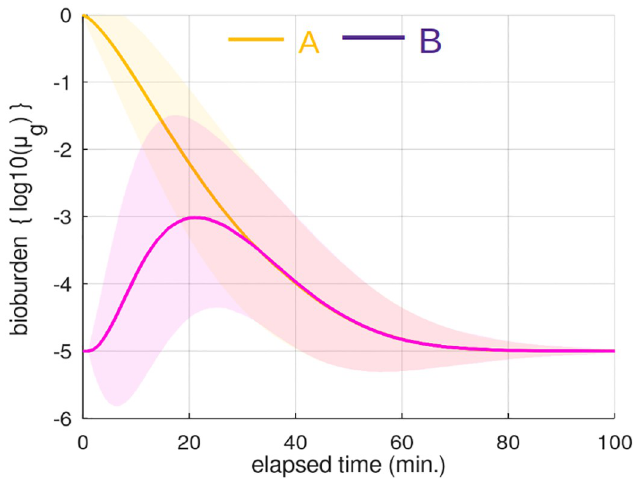
Fig 5. Bioburden. Geometric mean bioburden (log10 scale and normalised) and standard deviation (GSD) on TUIs A and B . A is initially contaminated. Over time microbes are transferred to B (0.1% avg. at 20 minutes) through sequential use. The eventual decay of both curves can be explained by pathogen die-off, personal-touching and the fact that 1/3 of people will visit only one location before leaving the simulation (mitigating further cross-contamination between A and B